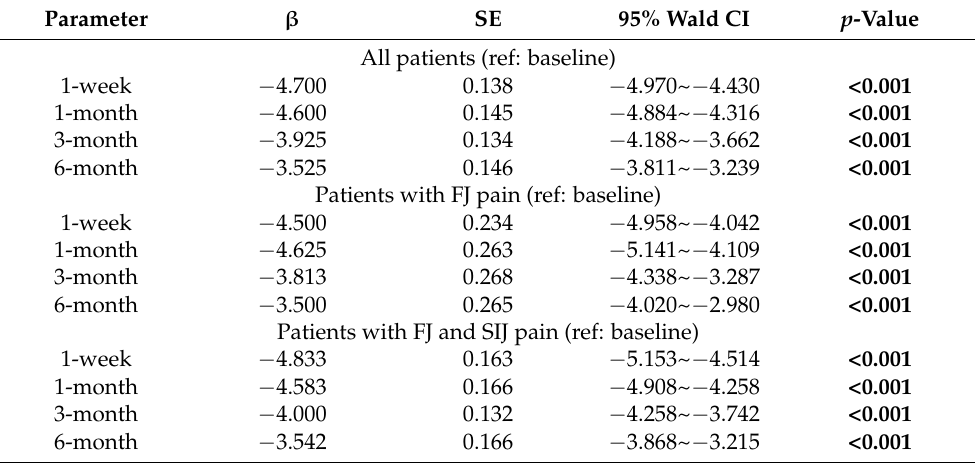
Table 2. Improvements in VAS scores from baseline to follow-up visits estimated by GEE after adjusting for age, gender, and BMI.